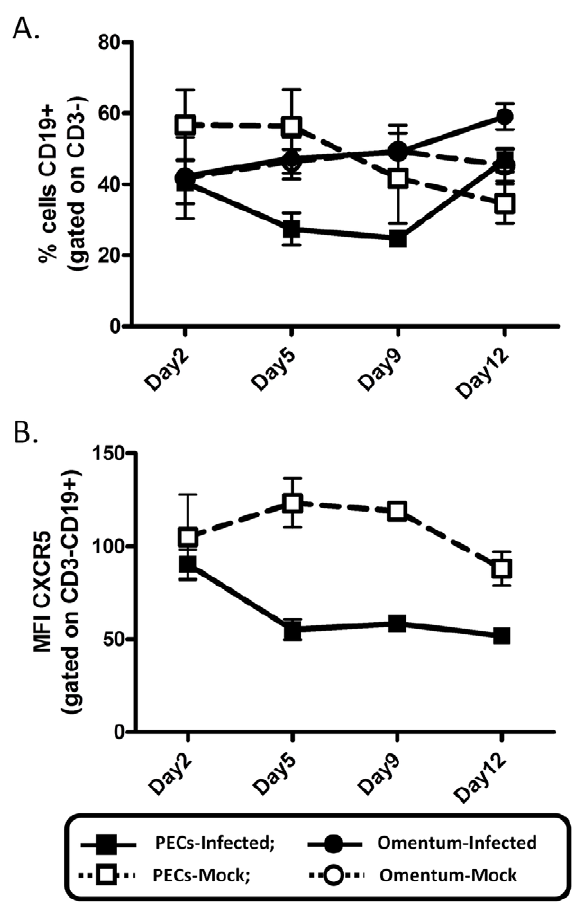
Figure 2. B cell populations in omentum and peritoneal exudate following MHV68 infection. Cells from the omentum and peritoneal cavity (PECs) were isolated at the indicated times post- intraperitoneal infection and analyzed by flow cytometry. Live cells were gated on A) CD3 2 and total B cells determined by CD19 expression or B) CD3 2 CD19 + cells to determine CXCR5